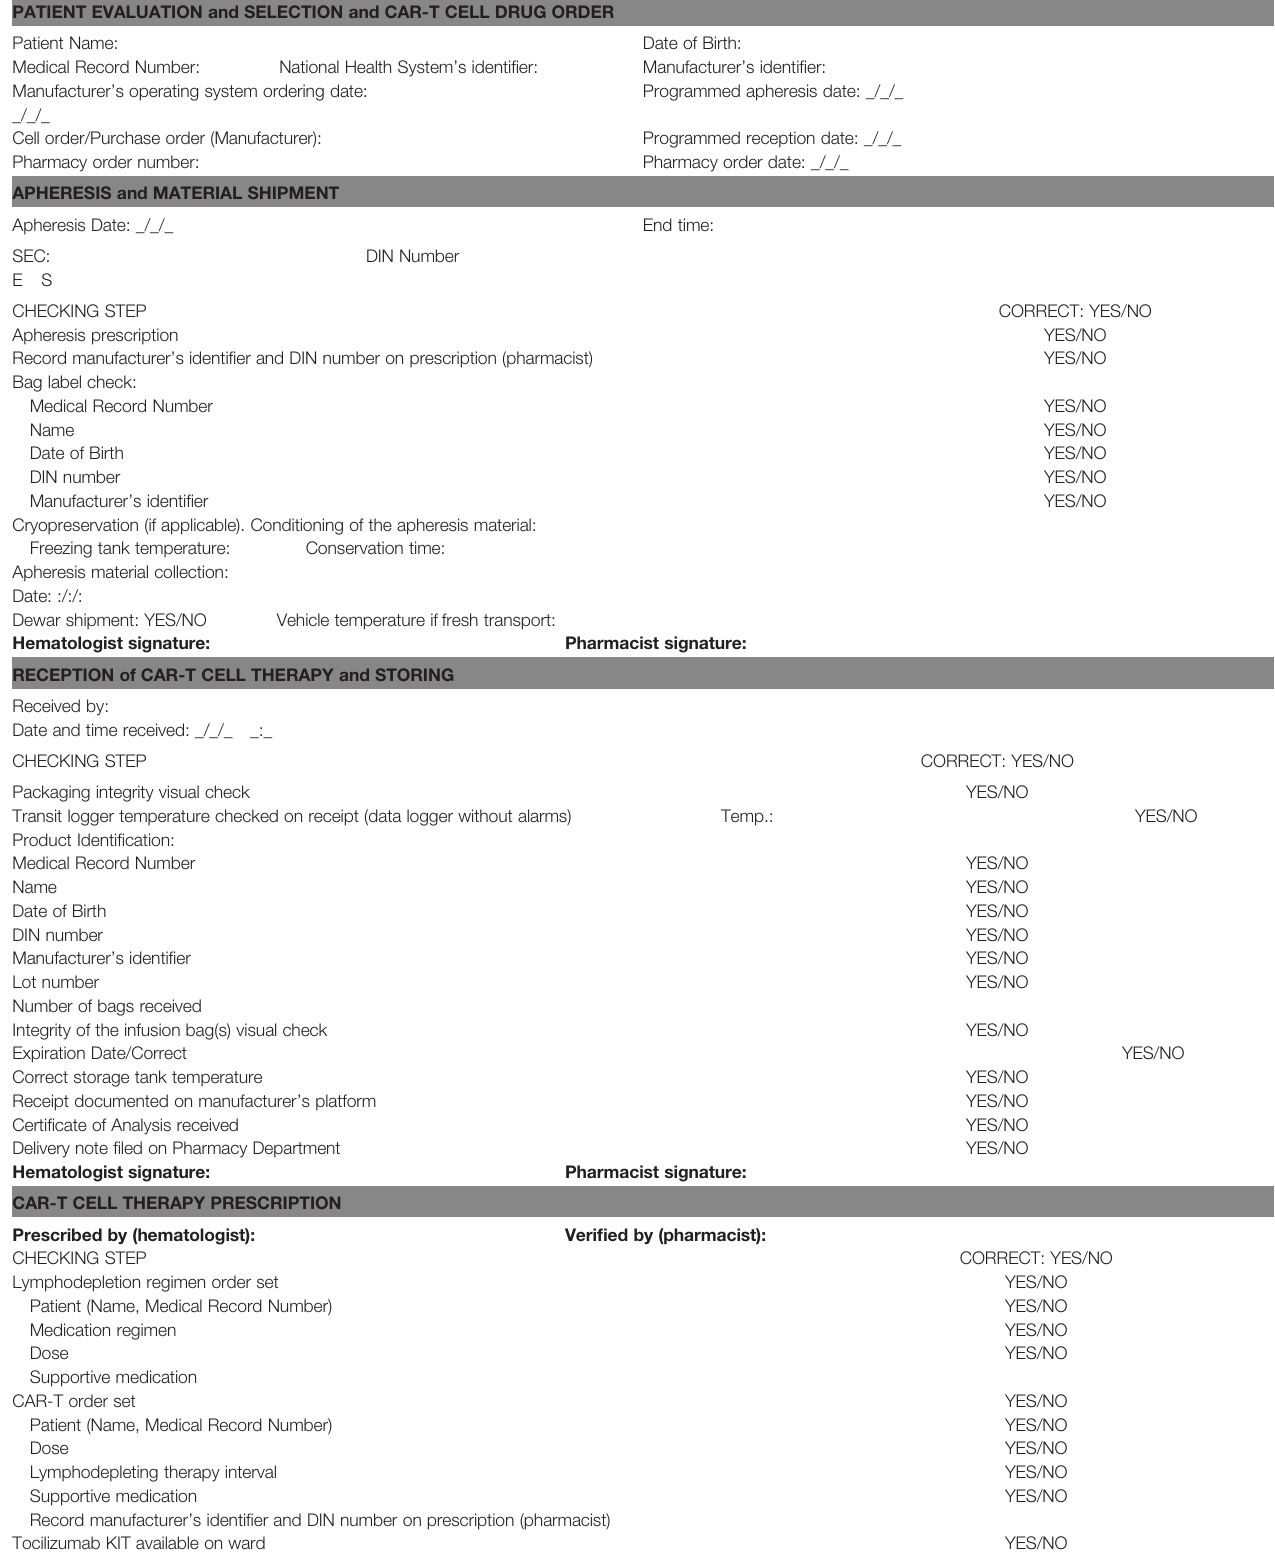
TABLE 1 | Guide supporting pharmaceutical responsibilities in the management and safety of CAR-T cell drugs. PATIENT EVALUATION and SELECTION and CAR-T CELL DRUG